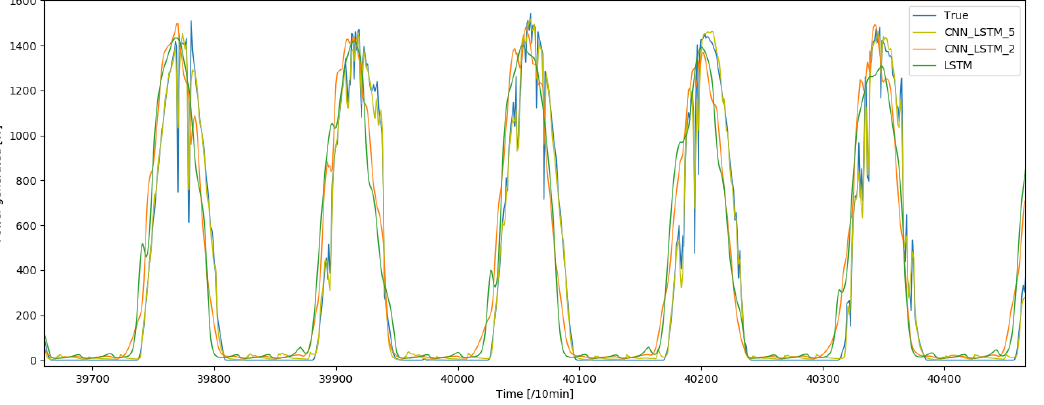
Figure 10. Prediction of PV generation during fall.